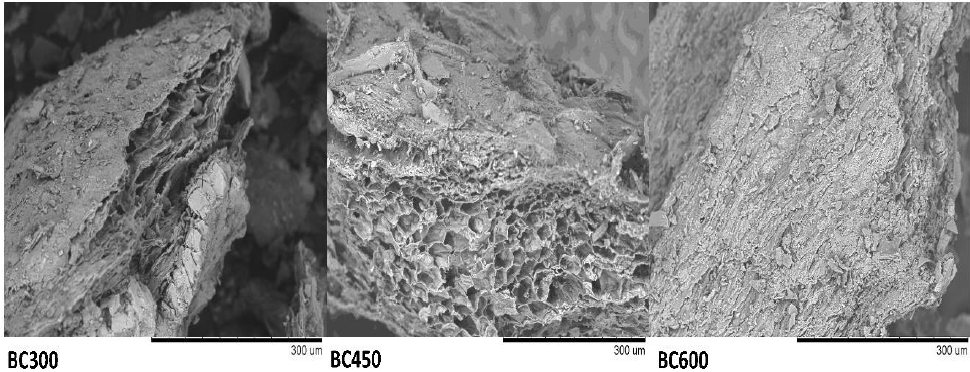
Figure 1. Micrographs obtained by scanning electron microscopy (SEM) of different biochar samples from Macrocystis pyrifera with a total magnification of 30,000×.